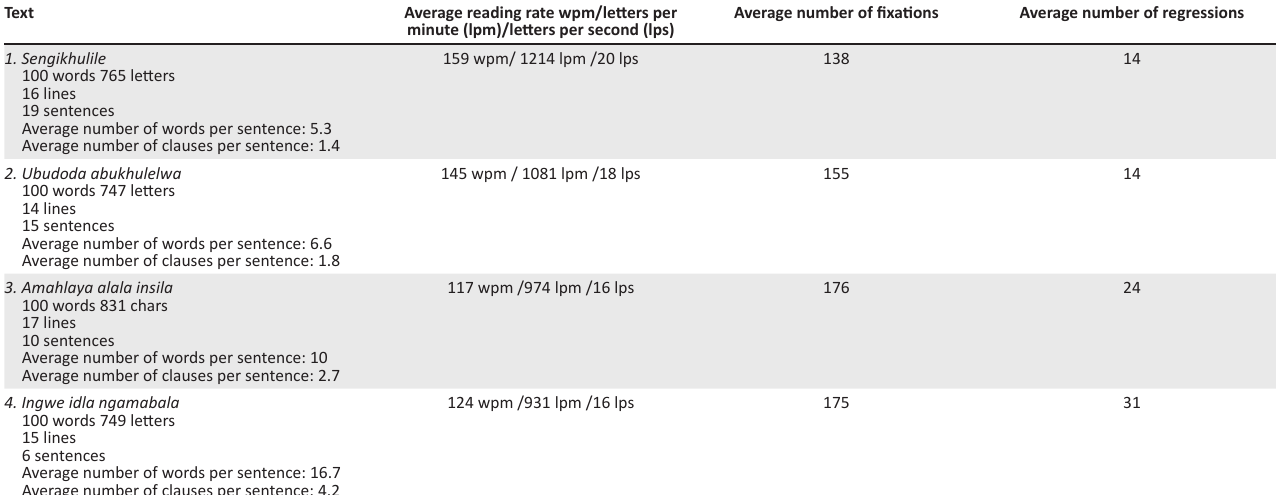
FIGURE 3: Eye movements of a reader with repeated regressions. TABLE 1: Measures of texts and average reading scores on each.